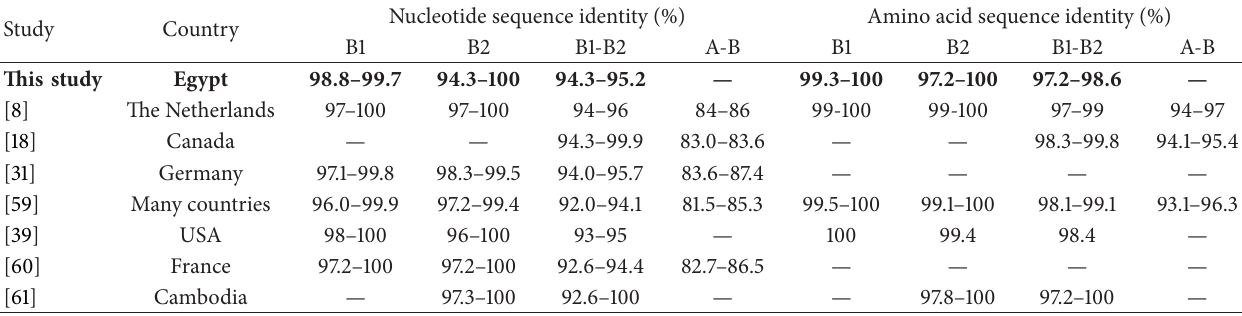
Table 5: Genetic similarity between and within HMPV subgroups and lineages (F, fusion gene).